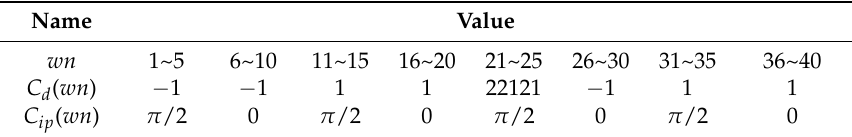
Table 1. The current direction C d and initial phase C ip for each